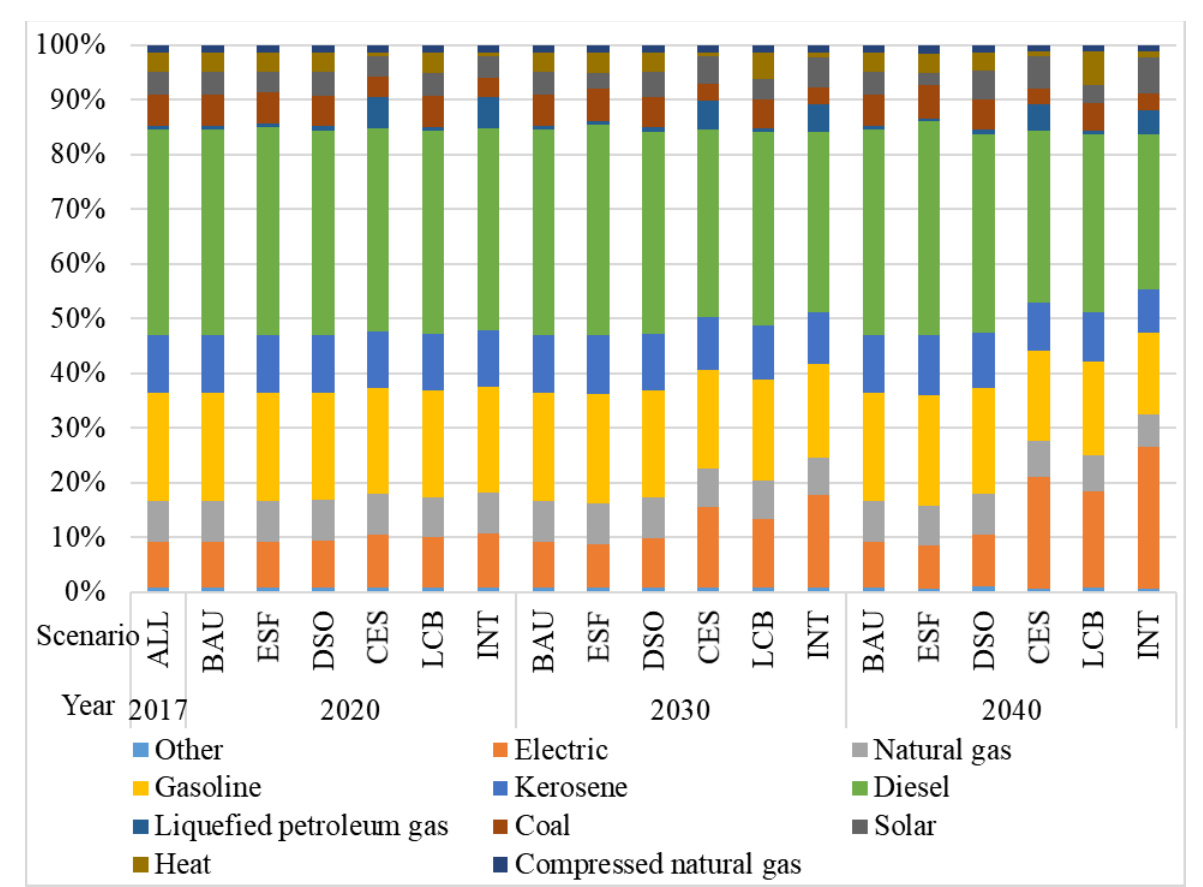
Figure 3. Change of fuel consumption demand under various scenarios.